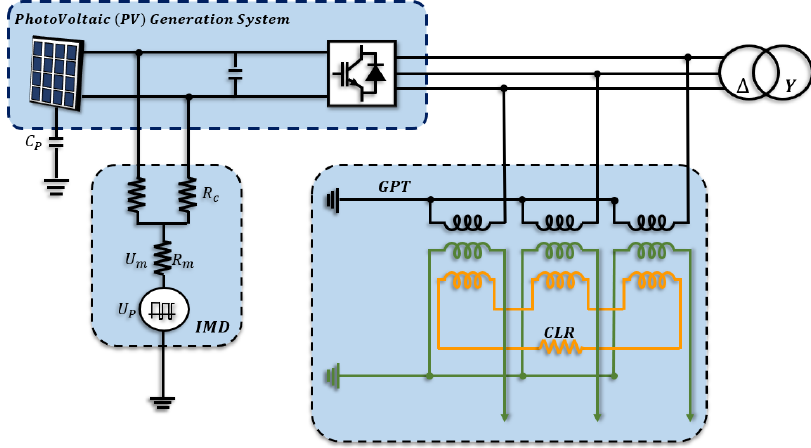
Figure 4. System configuration of problem scenario.